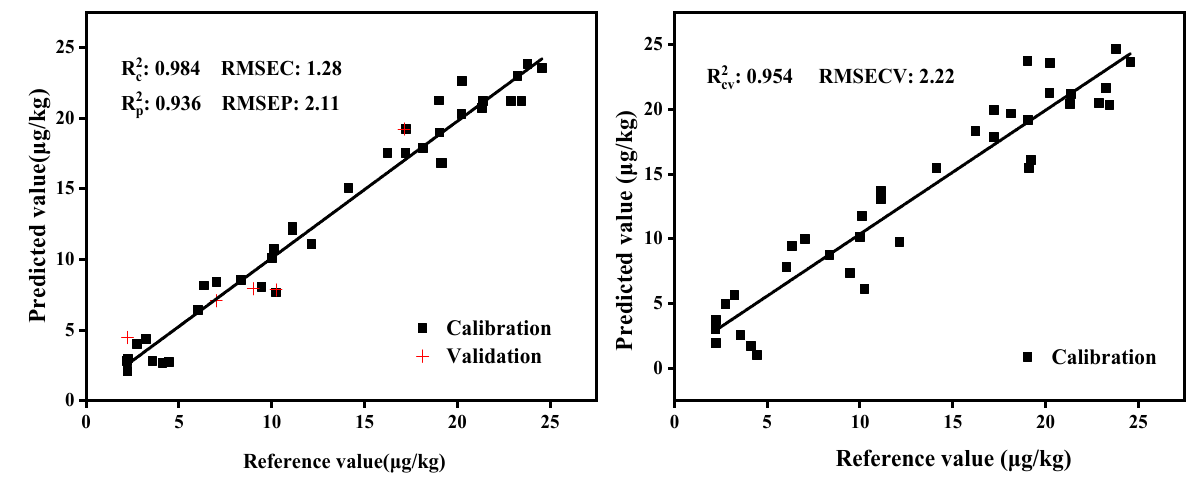
Figure 11. PLS model and cross-validation of the transmission module.